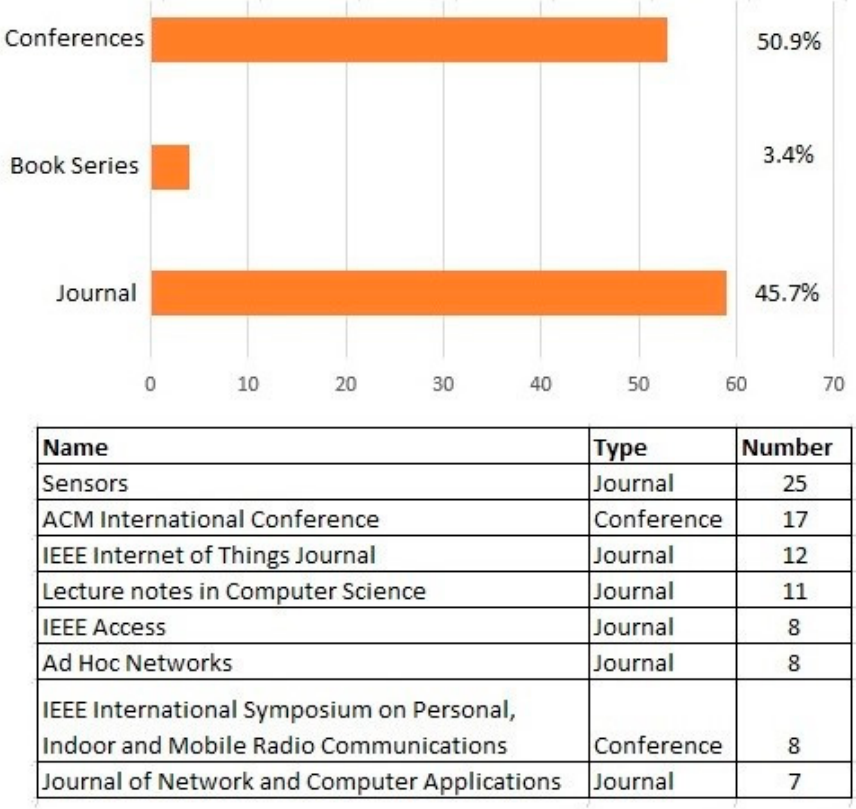
Figure 8. Type of papers about LoRa and IoT selected for the present study.